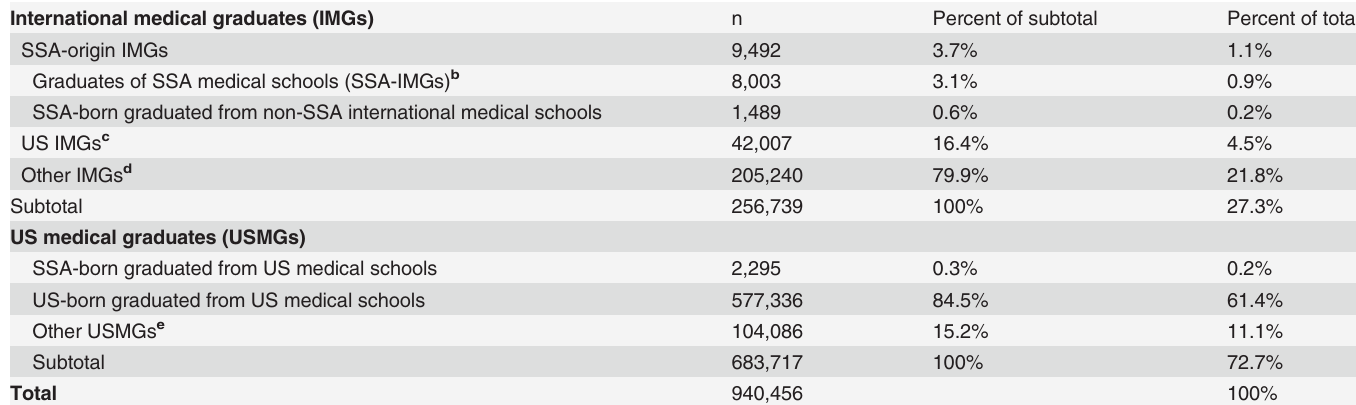
Table 2. Medical graduates a from Sub-Saharan Africa (SSA), the United States, and elsewhere in the December 2013 American Medical Associa- tion (AMA) Physician Masterfile. International medical graduates